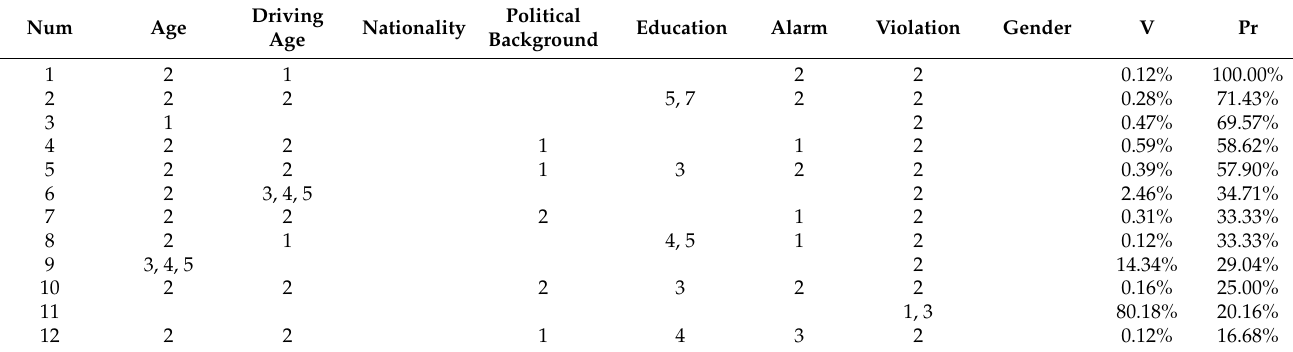
Table 12. Accident occurrence rule set.